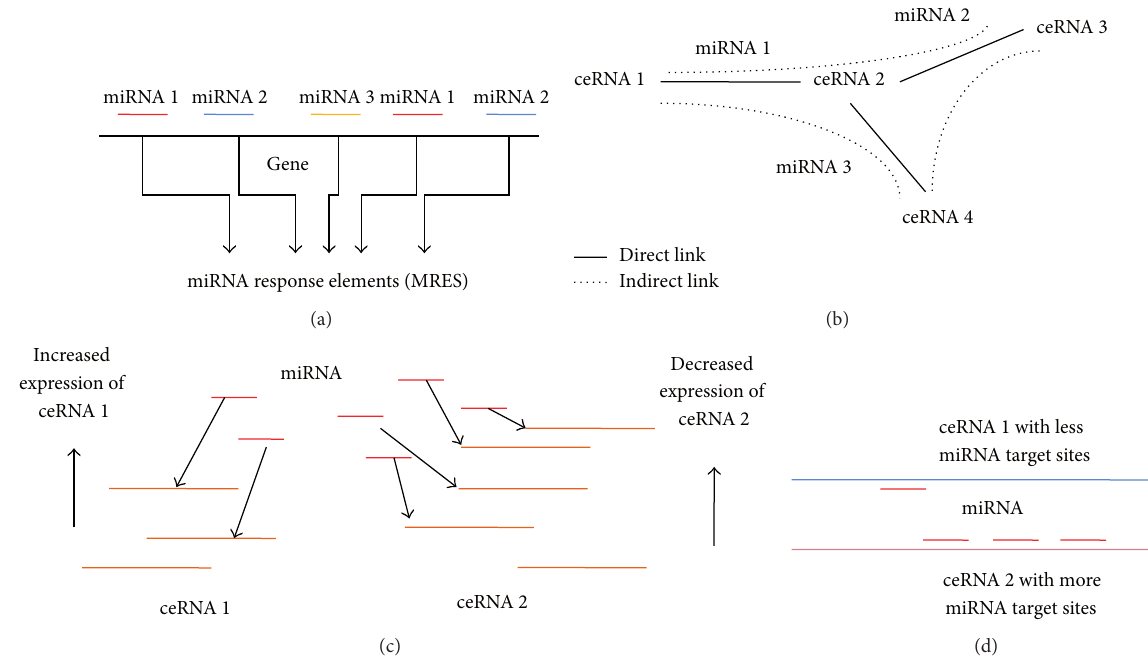
Figure 1: Determinants of ceRNA activity. (a) The direct and indirect linkage between ceRNAs in a network of four ceRNAs. ceRNA 1 and ceRNA 2 are directly linked by the common miRNA, miRNA 1, and ceRNA 2 and ceRNA 3 are linked by the common miRNA, miRNA 2. ceRNA 1 and ceRNA 3 are indirectly linked through ceRNA 2. (b) The effect of concentration of individual ceRNAs. ceRNA 2 has a higher level of expression than ceRNA 1 which drives the shared miRNAs more towards ceRNA 2 leaving ceRNA 1 free of repression. (c) The effect of number of MREs on ceRNAs for shared miRNAs. ceRNA 2 has more target sites for the shared miRNA (red) than ceRNA 1 so that the miRNA is more attracted to ceRNA 2. It results in increased ceRNA effect of ceRNA 2 on ceRNA